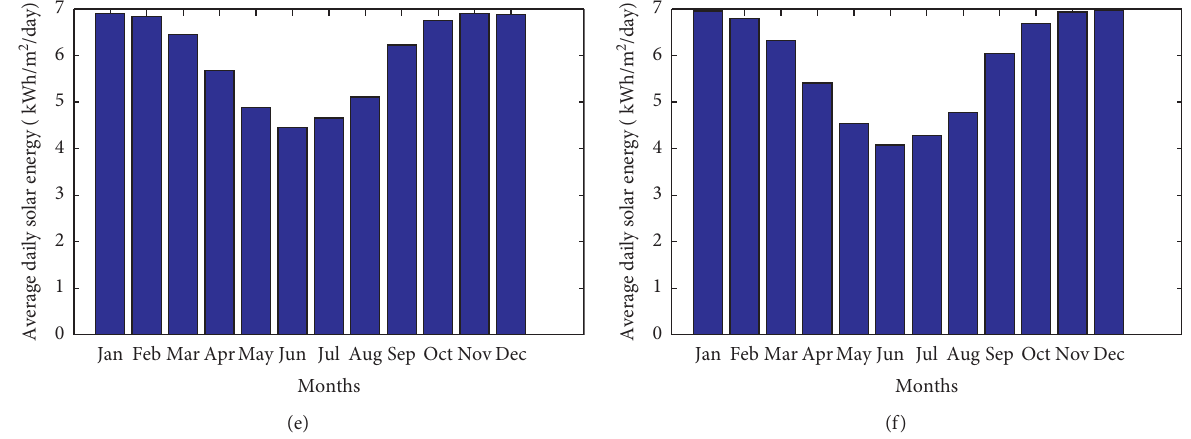
Jul ; (b) PV energy output at λ Aug ;